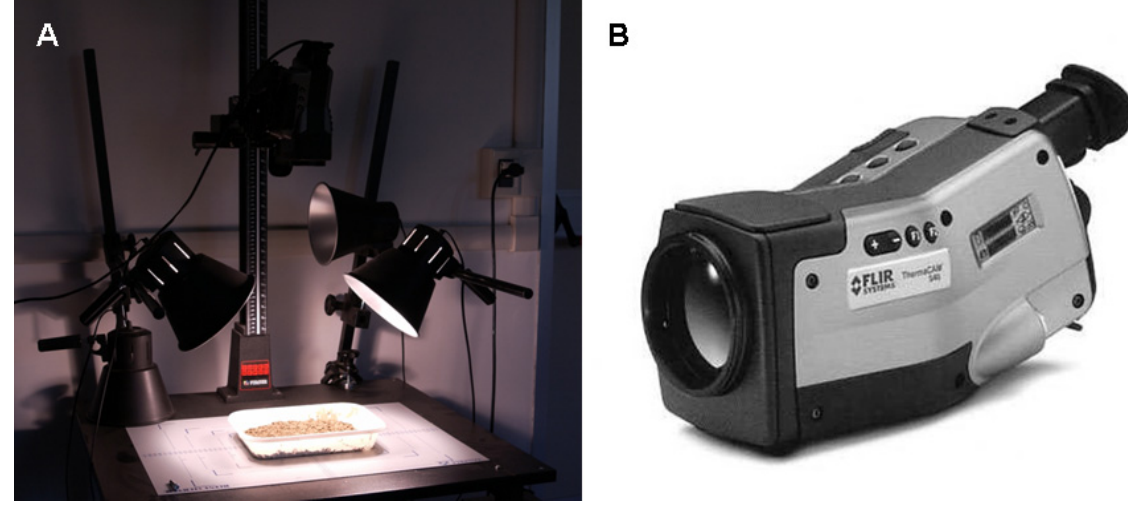
Figure 1. (A) Thermographic laboratory analysis system. Special photographic bulbs heating the soil samples in apposite plastic trays (20 × 30 cm) for the active infrared thermographic analysis. (B) Thermocamera FLIR